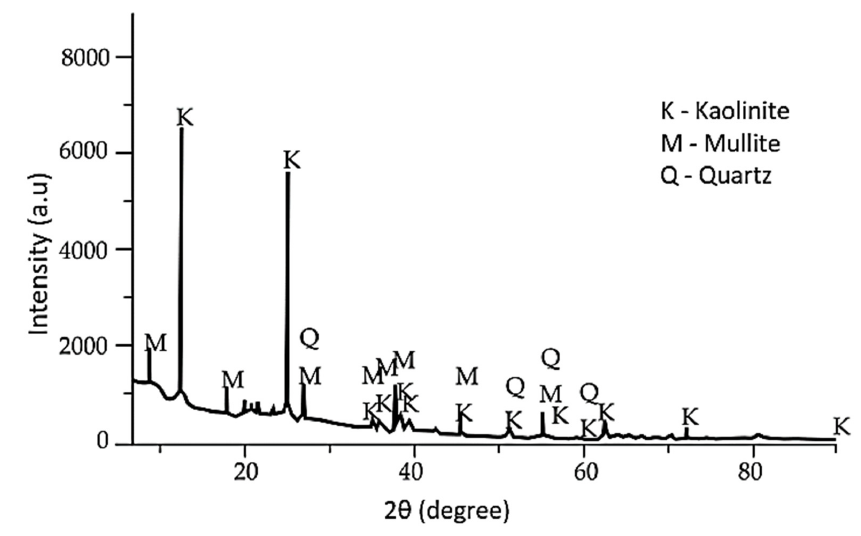
Figure 9. XRD patterns of kaolin (K) [51]. The XRD patterns for calcined kaolin and the comparable hydrates with and without additions are shown in Figure 10, where, relative to calcined kaolin, the kaolin-based ge- opolymer paste has less crystalline peaks. Several crystalline hydrated phases, including quartz (Q), muscovite (M), and gypsum, were discovered (G). The addition of NaOH or CaO has only a minimal impact on the crystalline phases of the resulting hydrates.